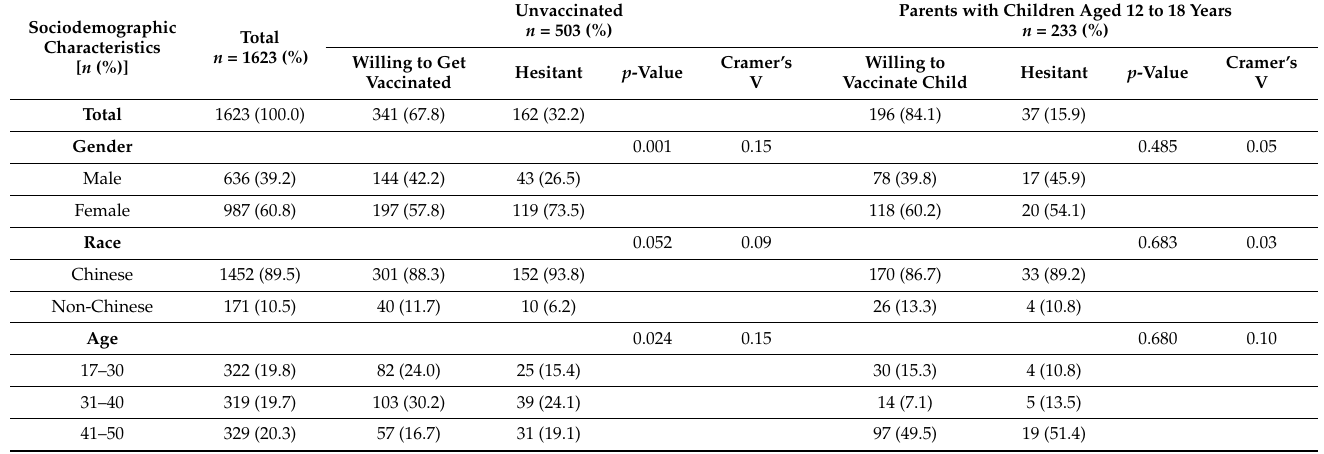
Table 1. Sociodemographic characteristics of participants ( n = 1623) and their associated vaccine hesitancy rates. Sociodemographic